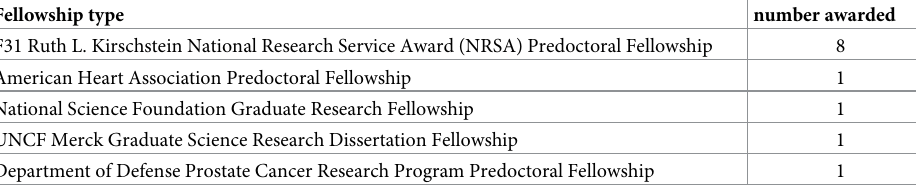
Table 3. Individual fellowships awarded to IMSD students matriculating from